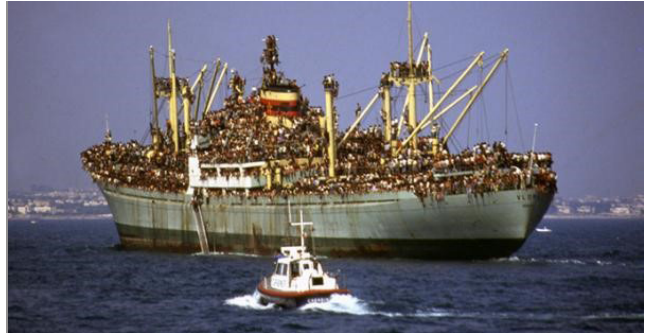
Fig. 2 The ship Vlora on 8 th August 1991 morning at the port of